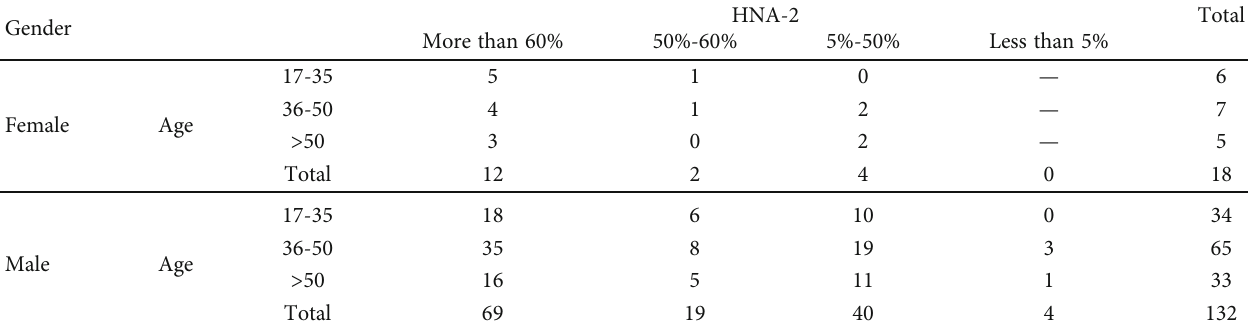
Table 5: Distribution of the HNA-2 among Iranian blood donors based on sex and